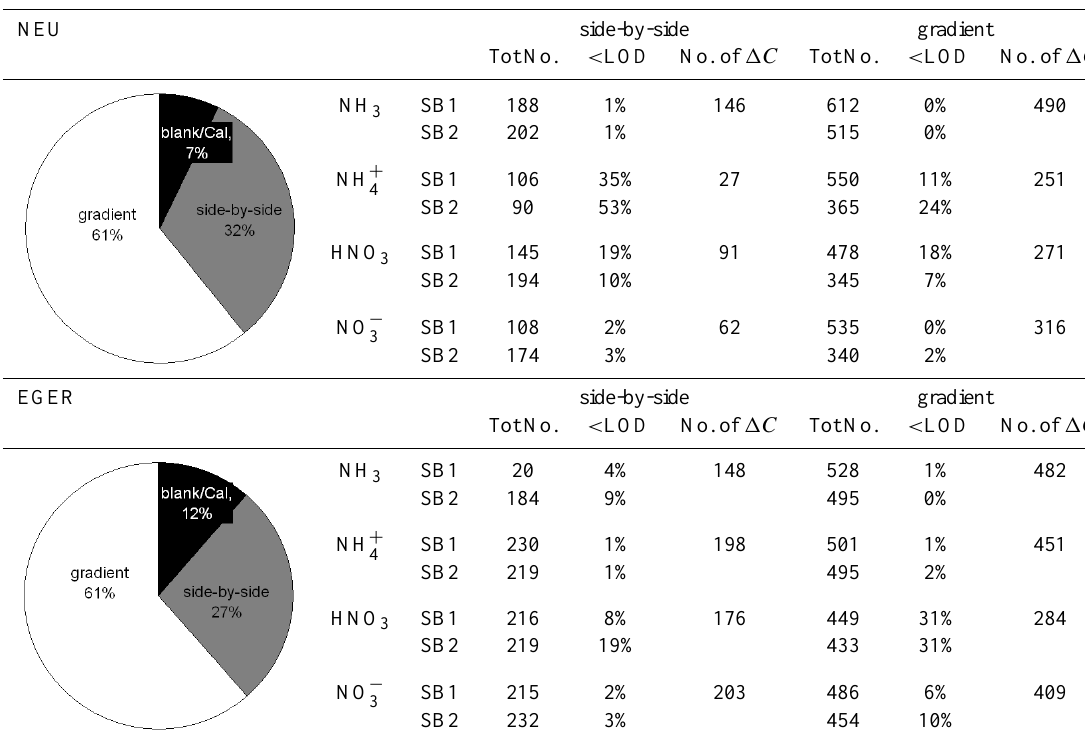
values > LOD were used.